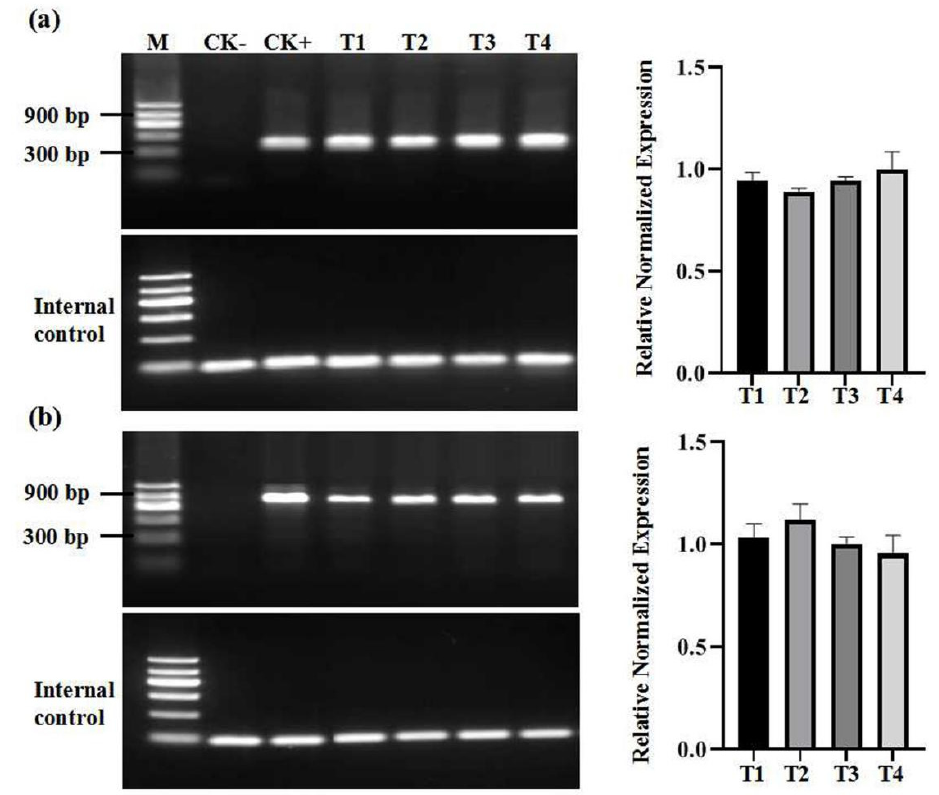
Figure 3. Assays of ( a ) GRLaV-2 and ( b ) GRSPaV in in vitro sub-culture of Cabernet Franc. M: maker II (Tiangen, China); CK-: negative control; CK+: positive control; T1-T4: passage number of in vitro sub-culture.